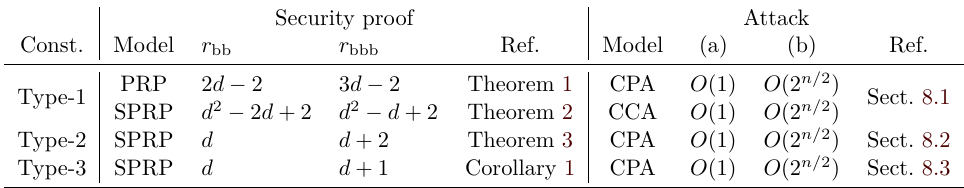
Table 2: Summary of distinguishing attacks against TBC-based GFSs. “Const.” is a dn